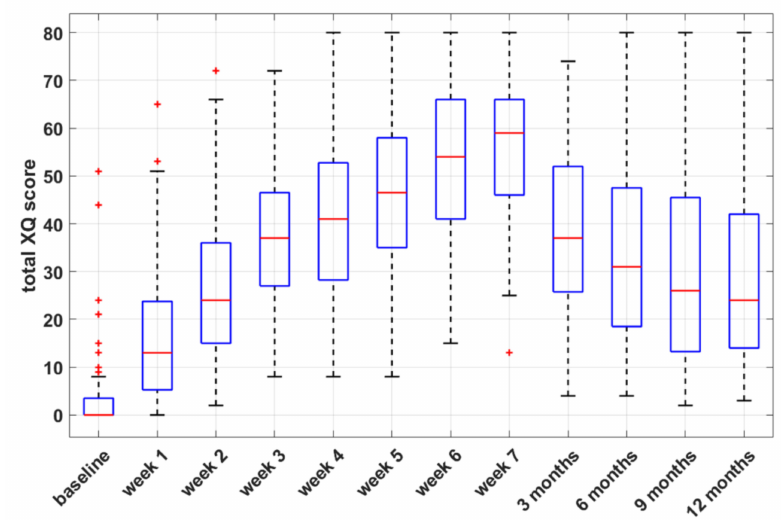
Figure 1. Box-and-whisker plots of self-assessed xerostomia-related questionnaire (XQ) scores versus time, during and after